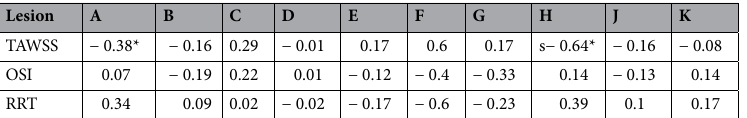
the vessel reconstruction (i.e. 2D angiography) and the lack of patient-specific boundary conditions may have affected the hemodynamic results in that study. More importantly, the analyzed arteries were only classified in